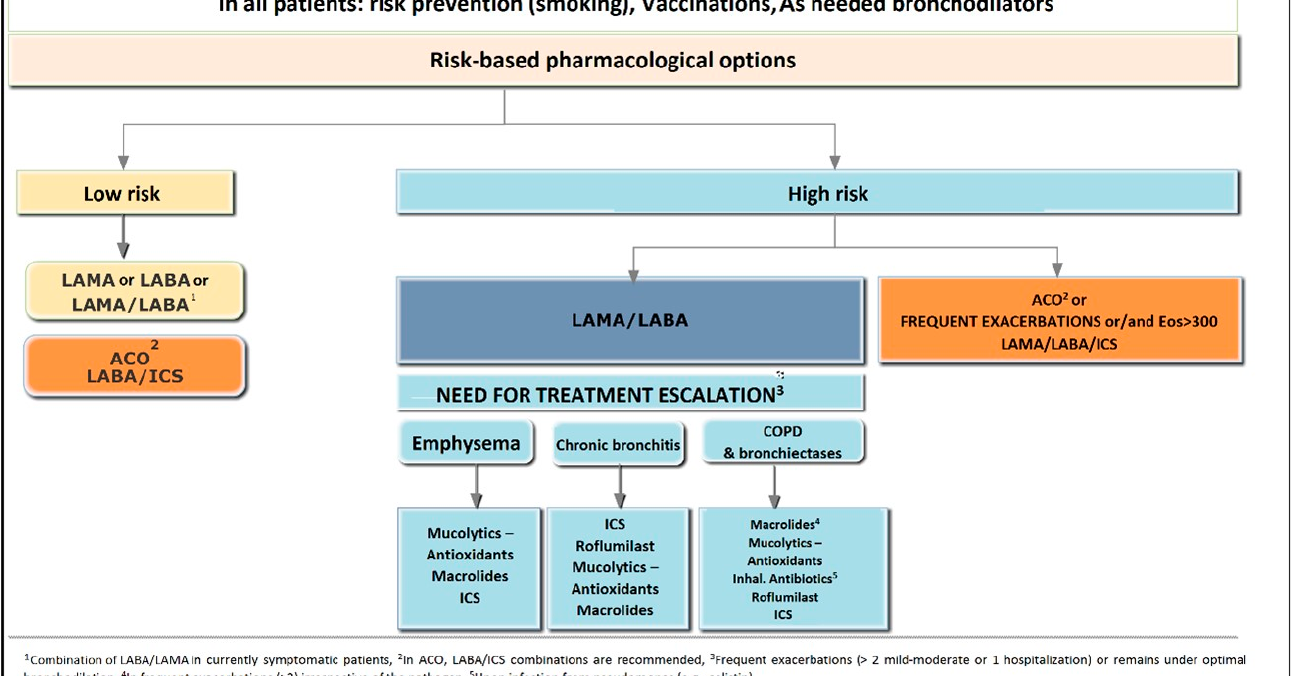
Figure 2. ( a ) Classification of prognostic risk. Footnote: 1 Carefully evaluate comorbidities. 2 Use LLNs in patients with borderline values, especially in patients <45 and >80 years of age. Abbreviation: LLN, lower limit of normal. ( b ) Treatment algorithm for stable COPD. Abbreviation: COPD, chronic pulmonary disease.